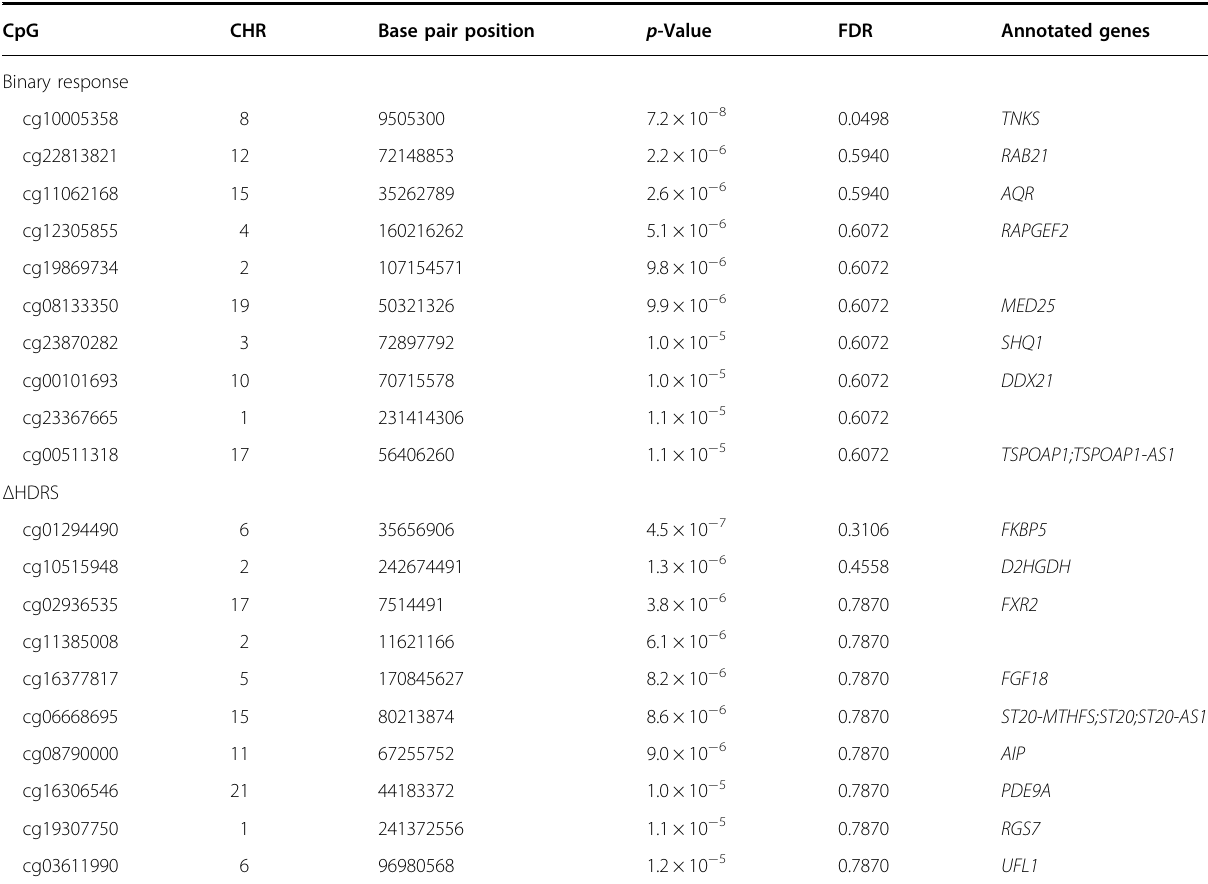
CpG cytosine-phosphate-guanine, CHR chromosome, FDR false discovery Table 3 Differentially methylated regions associated with Δ HDRS. CHR Base pair start - end Min p- value Number of probes Š ídák ’ s p- value Annotated genes